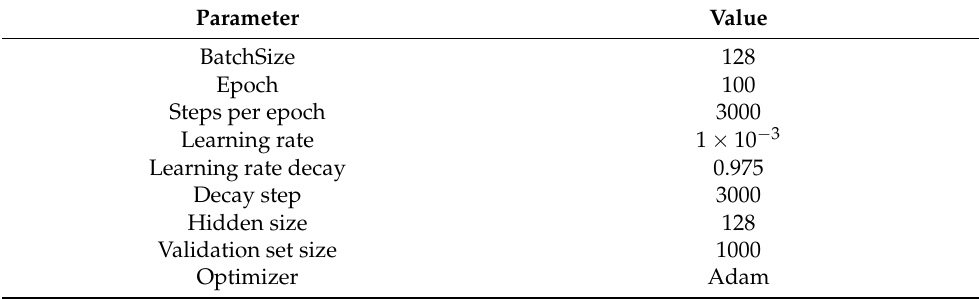
Table 2. Hyperparameter configuration.